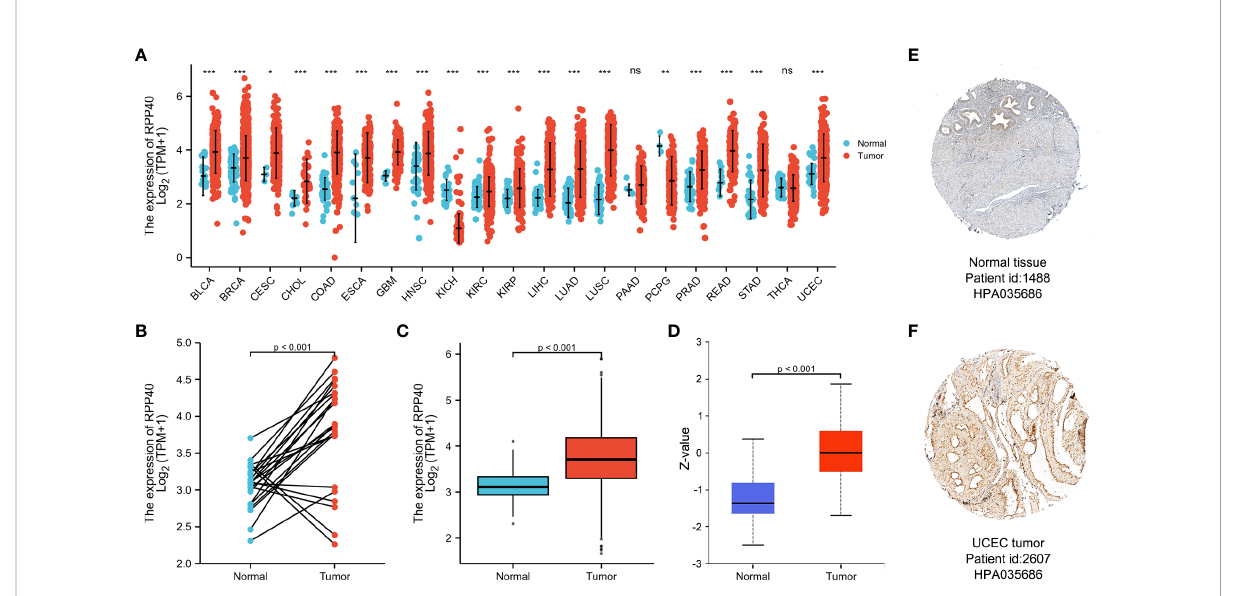
FIGURE 2 Expression of Ribonuclease P/MRP Subunit P40 (RPP40) in pan-cancer perspective. (A) The comparison of RPP40 mRNA expression between tumor and normal tissues in different cancer types based on the TCGA database. (B) Paired analysis of the mRNA expression levels of RPP40 in 23 UCEC samples and matched normal samples from the TCGA database. (C) Unpaired analysis of the mRNA expression levels of RPP40 in 552 UCEC samples and 35 normal samples from the TCGA database. (D) The protein expression difference of RPP40 between UCEC tumor tissues and normal endometrial tissues based on CPTAC. (E, F) The immunohistochemical staining of RPP40 protein in normal endometrial sample (E) and UCEC tumor sample (F) based on Human Protein Atlas. ns, P ≥ 0.05; * P < 0.05; ** P < 0.01; *** P <